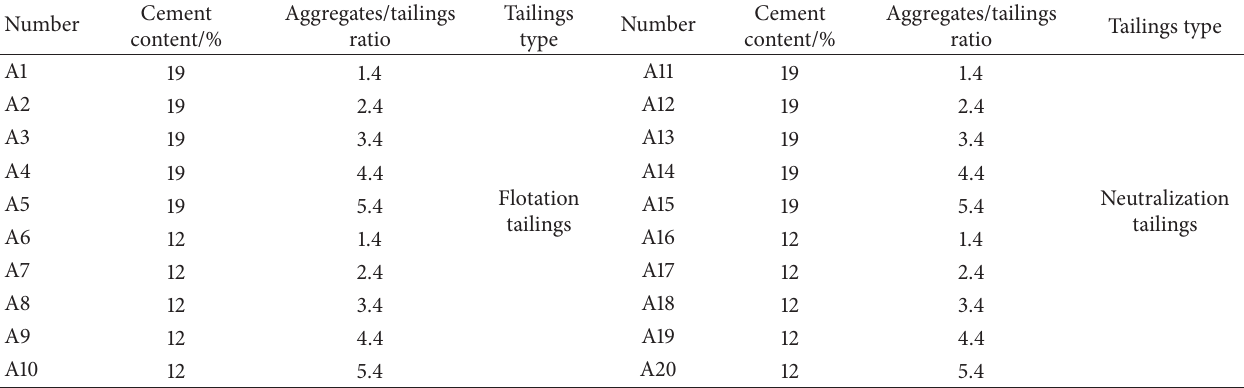
Table 1: Backfill mix design scheme for 75% density.